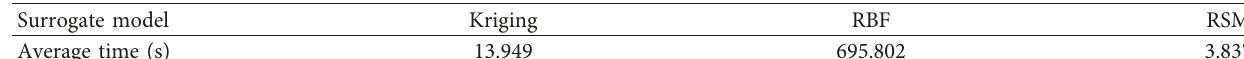
Table 3: Computation time.